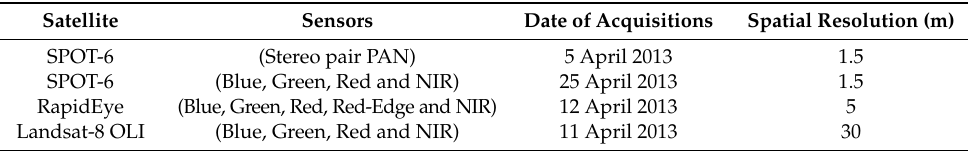
Table 1. Details of satellite data used.